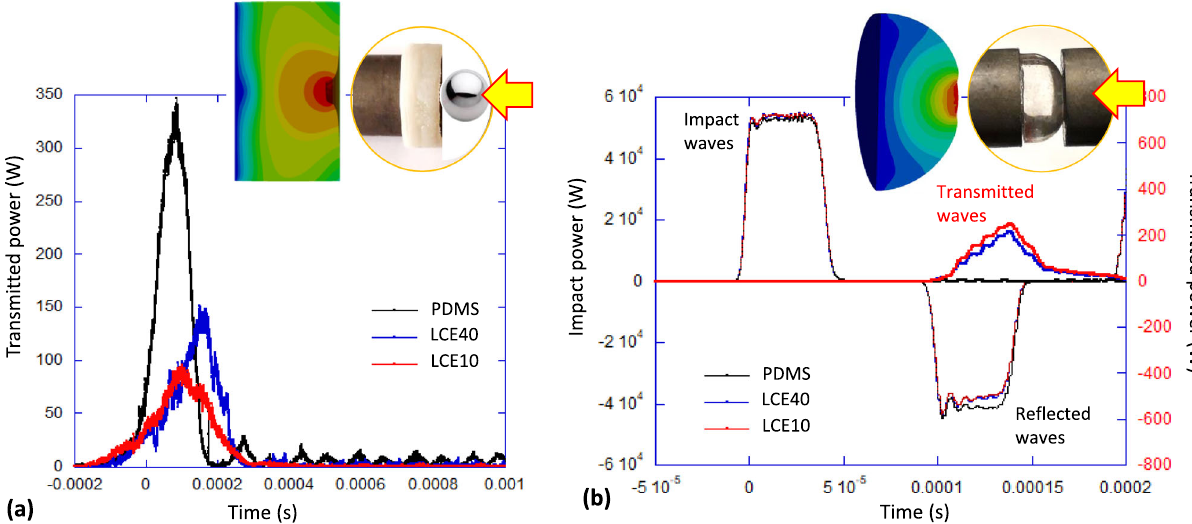
Fig. 3 Impact damping test. a Spherical ball impact on a fl at elastomer pad. The incident kinetic energy of ca. 3 J was partially transmitted through the elastomer into the receiving bar, the plot showing the power transmitted after the impact at t = 0 s. PDMS sample has 74% of impact energy dissipated, and clearly shows the under-damped oscillations after impact. Both LCE samples have dissipated over 90% of impact energy, and show the overdamped response both at the onset and after the force pulse. b Flat surface impact on a semi-spherical elastomer pad (of PDMS, LCE40 and LCE10), showing the low and heavily overdamped wave transmission: of the impact energy of 2 J, only 0.01 J (0.4%) was transmitted into the target rod by the LCEs while almost all energy was re fl ected by PDMS, with 28% of impact energy absorbed in the elastomers in this geometry. In both panels, the sketches illustrate the geometry of impact and the deformation fi eld distribution in the